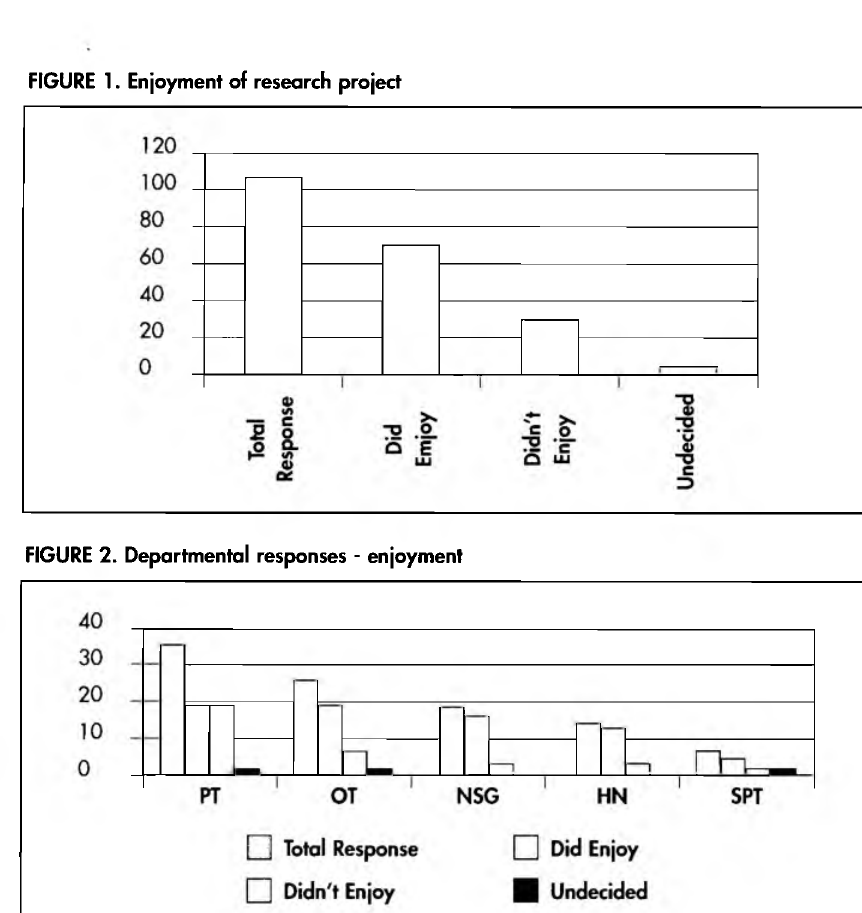
FIGURE 1. Enjoyment of research project